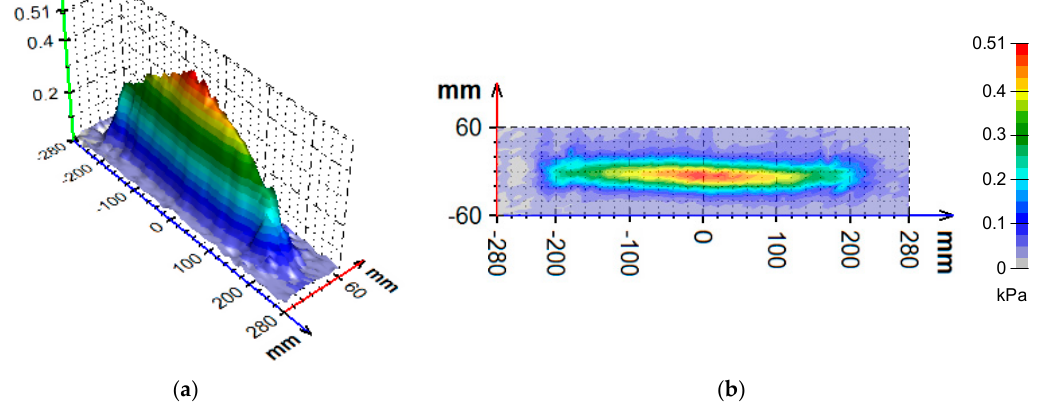
Figure 6. Impact pressure distribution for experiment E9. 3D chart ( a ); 2D chart ( b ).